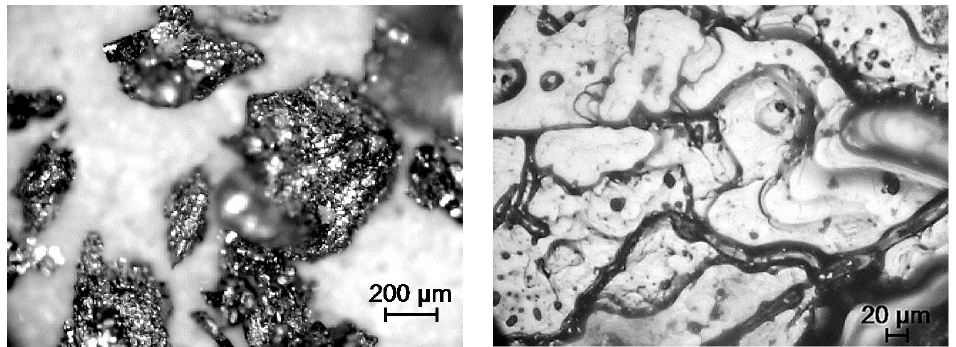
Figure 9. X-ray pattern of intermetallic compound crystals Al 3 Er.